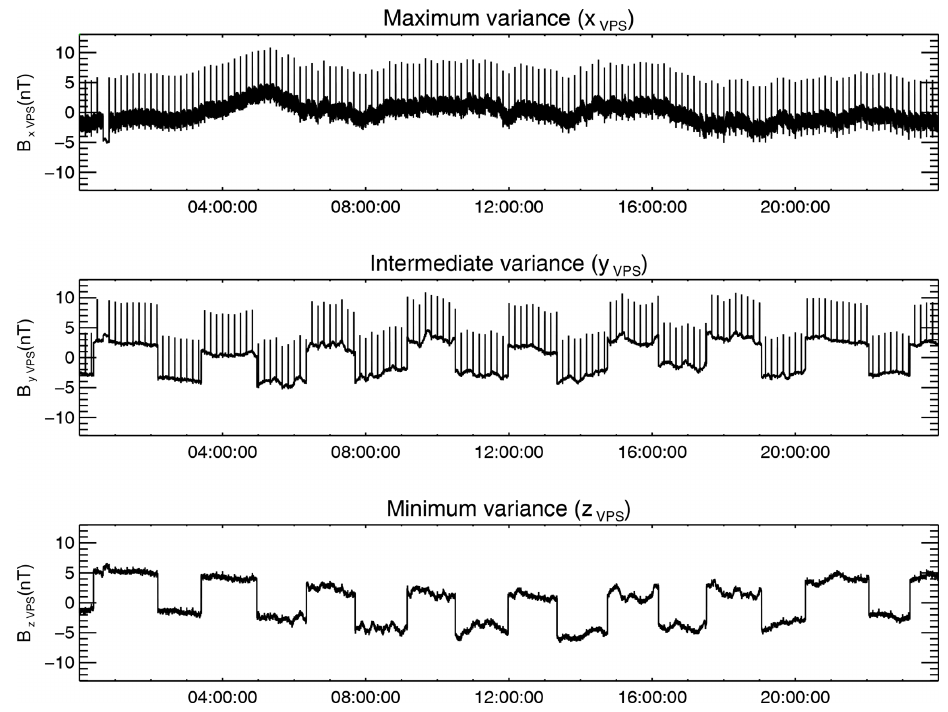
Figure 2. The difference (cid:49)B st before the first-order correction was applied, represented on components in its corresponding VPS (the x axis is aligned with the maximum-variation direction of (cid:49)B st ). The mean values were subtracted from all